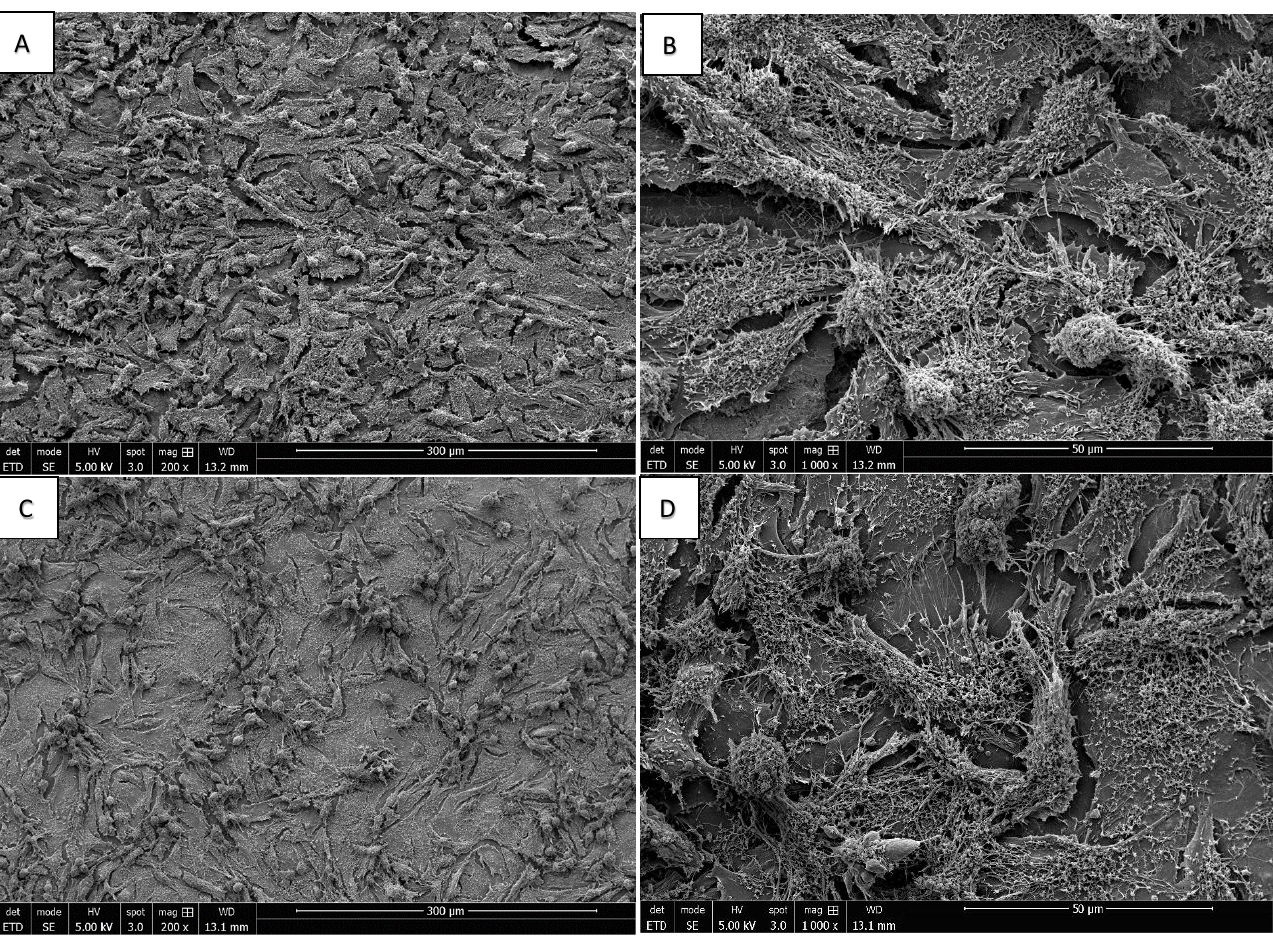
Figure 7. SEM image of Saos-2 cells on rough (( A ) magnification 200×; ( B ) magnification 1000×) and mirror-polished (( C ) magnification 200×; ( D ) magnification 1000×) surfaces of Y-TZP discs at 96 h of incubation.